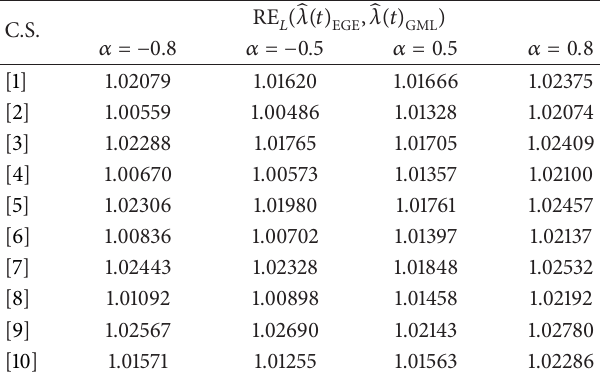
̂𝜆(𝑡) with respect to EGE